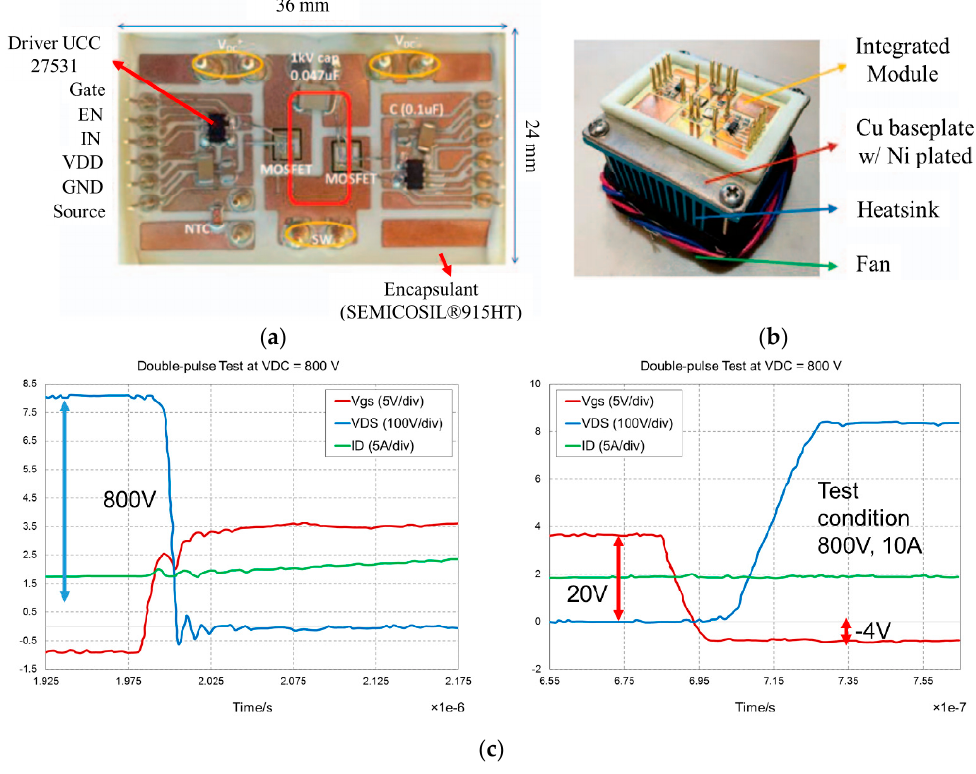
Figure 5. A 3.68 MHz SiC power module from the FREEDM center at North Carolina State University [35]. EN: enable; IN: input; VDD: drain voltage; and GND: ground. ( a ) A photograph showing the top view of the module; ( b ) a photograph showing the whole module assembly with the heat sink; and ( c ) test waveforms showing the switching characteristics of the module. Reprint with permission [4062731030342]; Copyright 2015, IEEE.